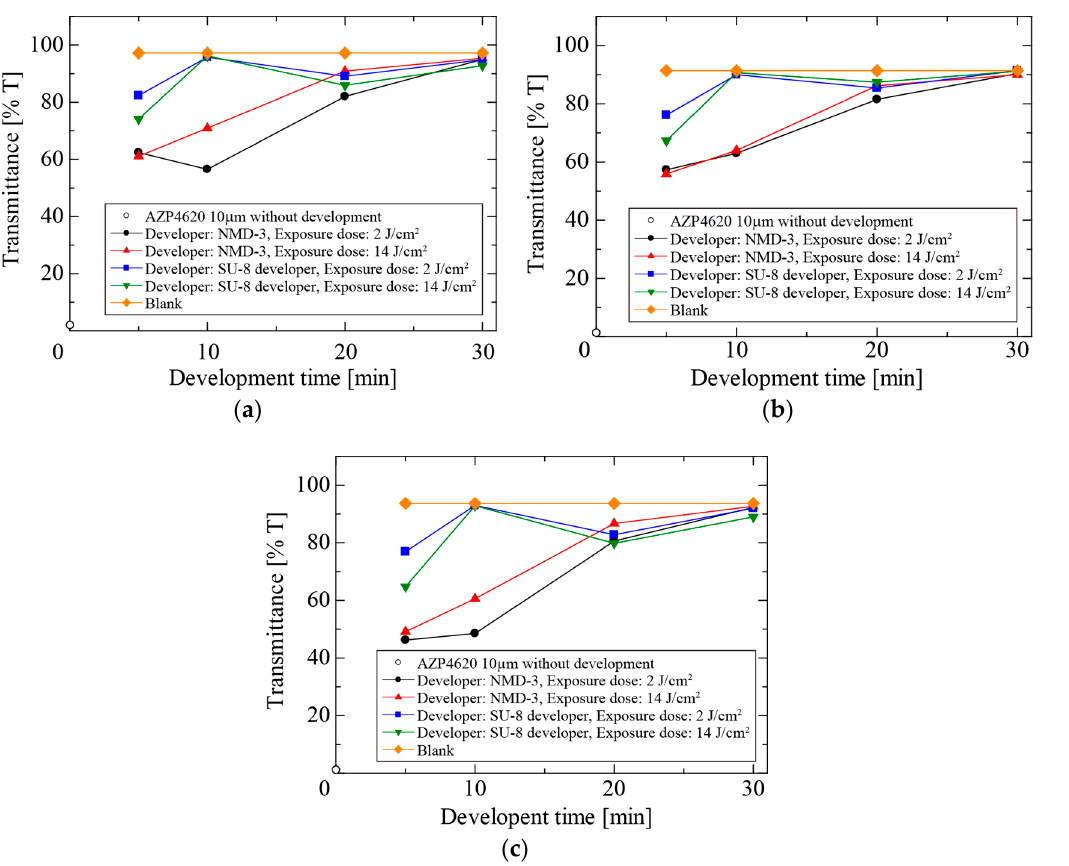
Figure 8. Transmittance vs. development time at ( a ) g-; ( b ) h-; and ( c ) i-line.